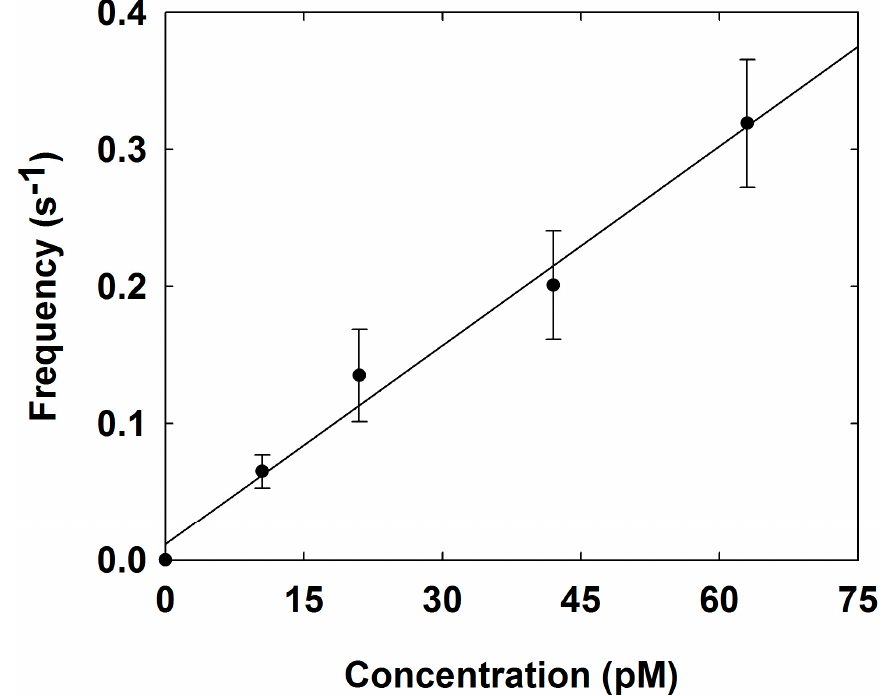
Figure 4. Collision frequency as a function of Pd NP concentration at an applied potential of − 0.15 V at the Au UME in a 0.1 M PB solution containing 20 mM H 2 O 2 (for 4 replicate measurements).